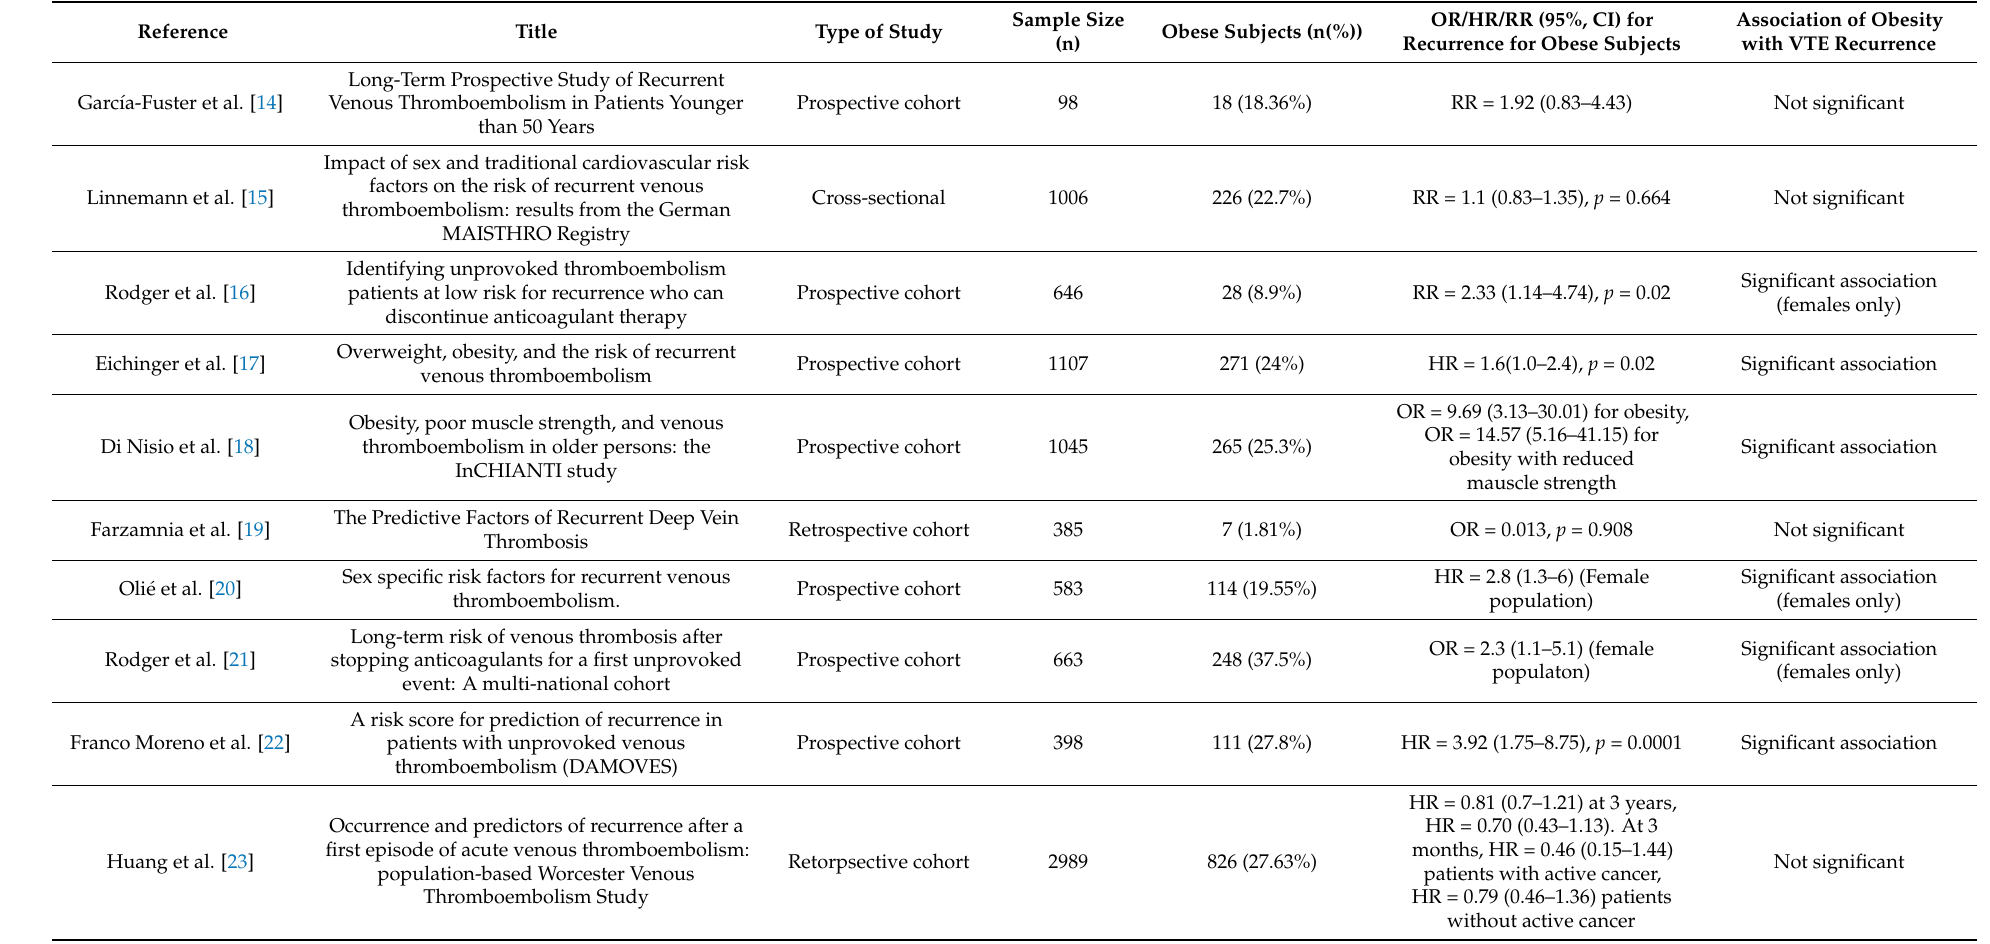
Table 2. The studies’ results. Abbreviations: BMI (kg/m 2 ); VTE: Venous thromboembolic disease; DVT: deep venous thrombosis; PE, pulmonary embolism; m, mean; md, median, y, years; mo, months; n, absolute number; NA: Not available or not applicable., Data are presented as mean ± SE, Data are presented as mean